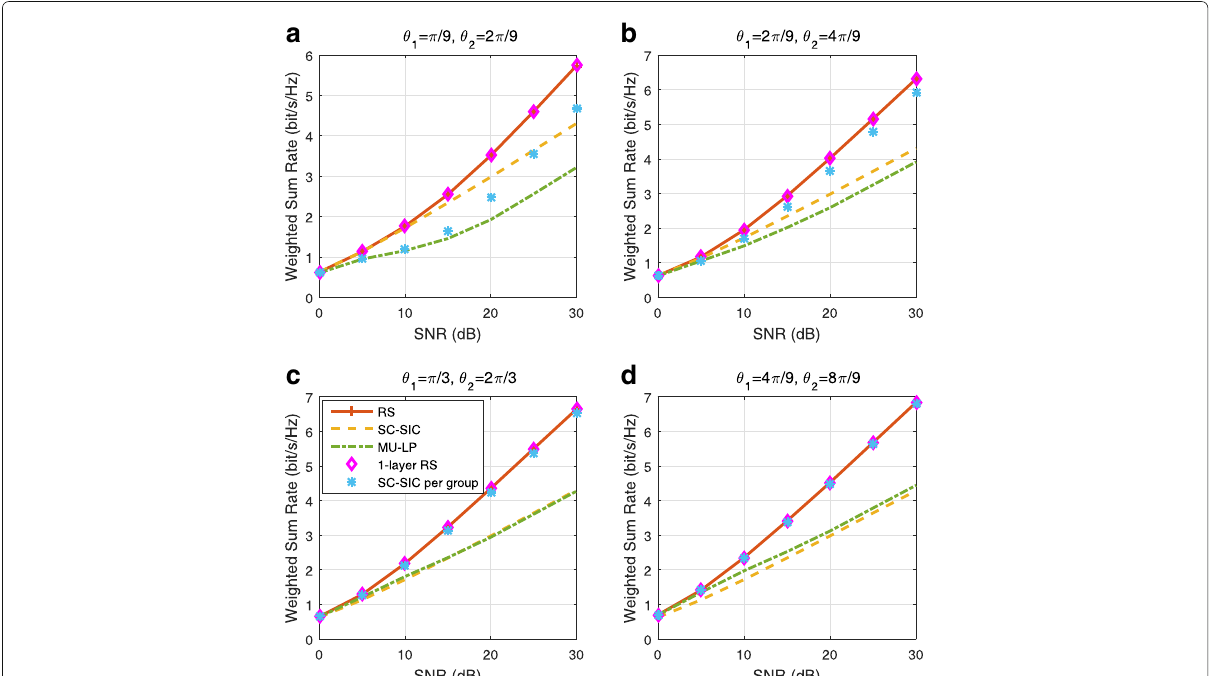
Fig.40 WeightedsumrateversusSNRcomparisonofdifferentstrategiesforoverloadedthree-userdeploymentwithperfectCSIT, γ 1 = γ 2 = 1, u 1 = 0.4, u 2 = 0.3, u 3 = 0.3, N t = 2, r th = [0.02,0.08,0.19,0.3,0.4,0.4,0.4] bit/s/Hz. a θ 1 = π/ 9, θ 2 = 2 π/ 9. b θ 1 = 2 π/ 9, θ 2 = 4 π/ 9. c θ 1 = π/ 3, θ 2 = 2 π/ 3.